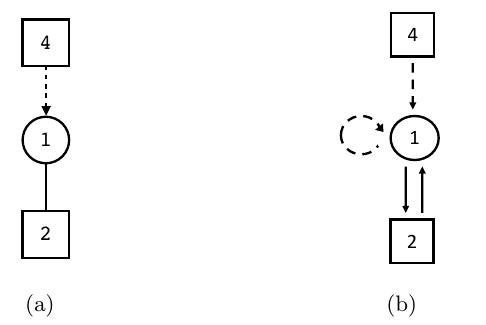
Figure 4 . (a) A sample quiver diagram with nodes and arrows representing N = (0 ; 4) multiplets. A circular node with a positive integer k represents a U( k ) gauge group and the corresponding vector multiplet. A square box with a positive integer N represents a (cid:13)avor symmetry group U( N ). A solid line (or a dashed arrow) from a U( n 0 ) node to a U( n ) node represents a hypermultiplet (or respectively a short Fermi multiplet) in the bifundamental representation ( n ; n 0 ) of U( n ) (cid:2) U( n 0 ). We used an arrow, not just a line, to indicate N = (0 ; 4) a short Fermi multiplet because an orientation is needed to specify the representation. (b) The equivalent quiver diagram with nodes and arrows representing N = (0 ; 2) multiplets. In this case each line needs to be equipped with an arrow to specify the